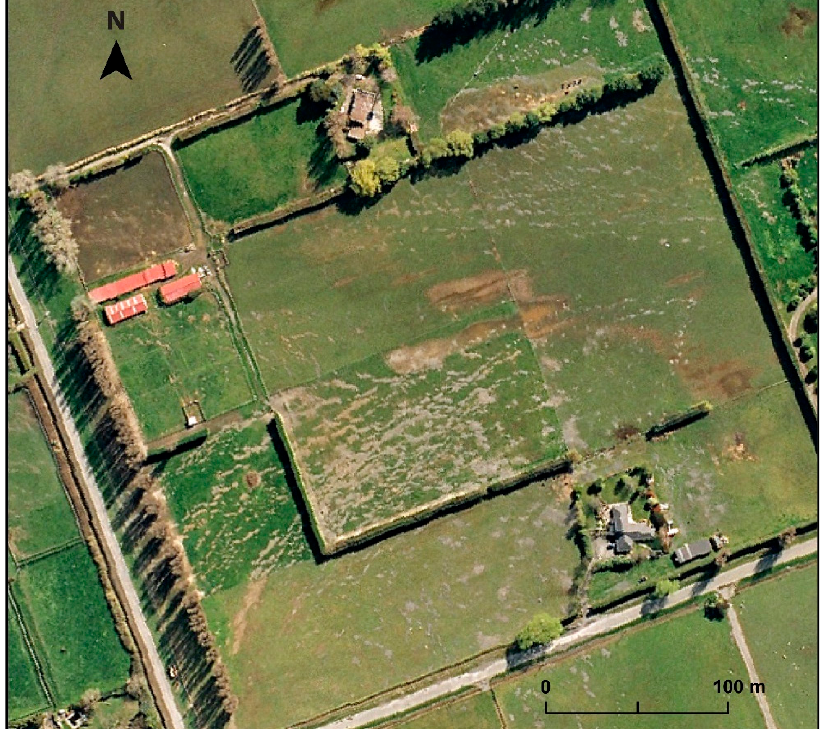
Figure 10. Aerial photograph showing gray-colored sand blows that formed at the Hardwick site on the floodplain of the Halswell River south of Christchurch during the 4 September 2010, M 7.1, Darfield earthquake (modified from Reference [160]).